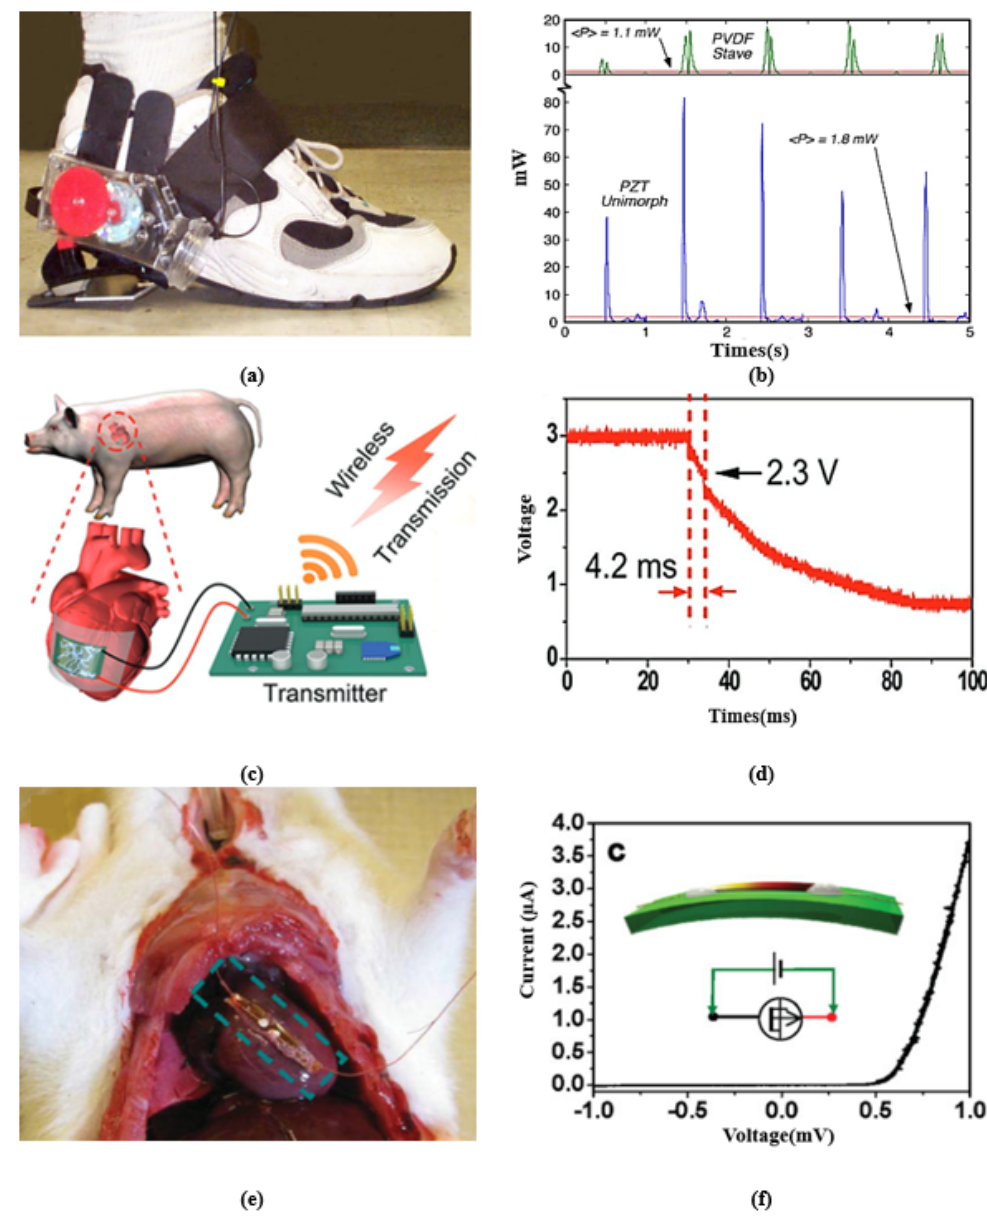
Figure 4. ( a ) A shoe-mounted rotary energy generator. ( b ) Output power from shoe-mounted rotary energy generator. Reprinted with permission from [91]. Copyright 1998 IEEE. ( c ) Flexible